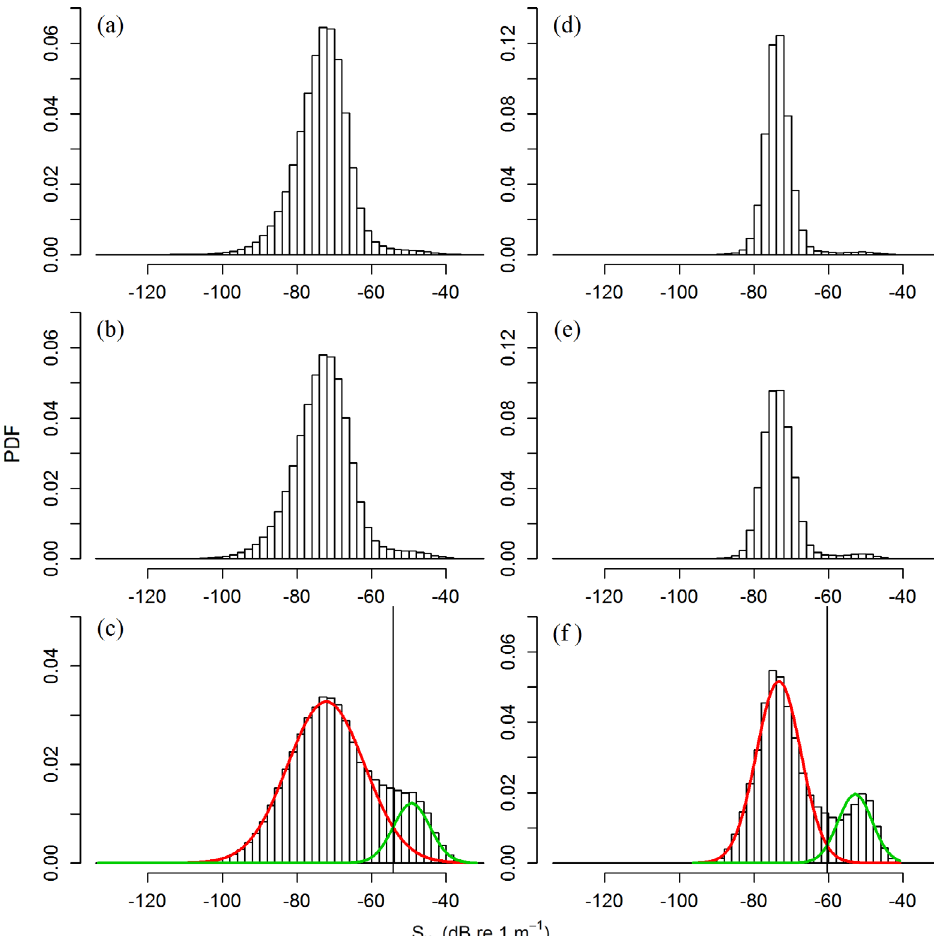
Fig. 2. Histograms for the different sets of data associated to haul no. 4 explained in Figure 1. The left panel histograms correspond to (a) the raw S v data for the whole echogram (excluding sea bottom); (b) the fi rst 100 m from the surface; and (c) the rectangular area enclosing the schools. The histograms of the averaged S v data for the same sets are represented in the right panels (d, e and f). The red and green lines in the bottom histograms are the Gaussian PDFs fi tted by the EM algorithm to the weak and strong (likely the schools) echoes. The black vertical lines in (c) and (d) represent the optimal thresholds found for both sets, (cid:1) 54.2 and (cid:1) 60.4dB,